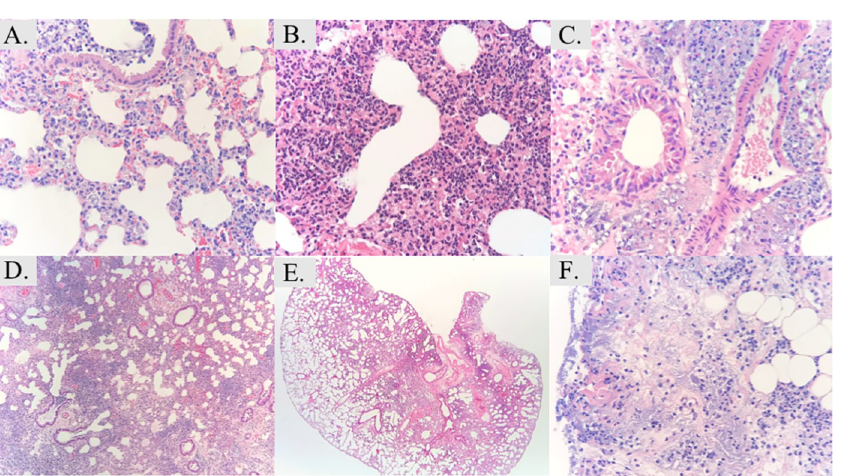
Fig 9. Histopathology of the lungs at 18 hr post infection in the pneumonia model. Severe hemorrhagic pneumonia is seen at 18 hours. A) Representative image of HUMC1-infected lung showing relatively mild acute insterstitial inflammation (400X magnification). B) VA-AB41 infection resulted in a heavy interstitial neutrophilic response (400X magnification). C) In LAC-4 Col R infected lung, heavy organism load is accompanied by an exuberant neutrophilic infiltrate adjacent to bronchovascular structures (400X magnification). D) HUMC1-infected lung: low power examination illustrates expansion of interstitium by acute inflammation and distortion of normal air space architecture (50X magnification). E) Lung infected by VA-AB41 on low scanning power examination shows central distribution of the infectious process in this mouse model (25X magnification). F) LAC-4 Col R lung infection showed areas of tissue necrosis associated with high bacterial burden and acute inflammation (400X magnification).